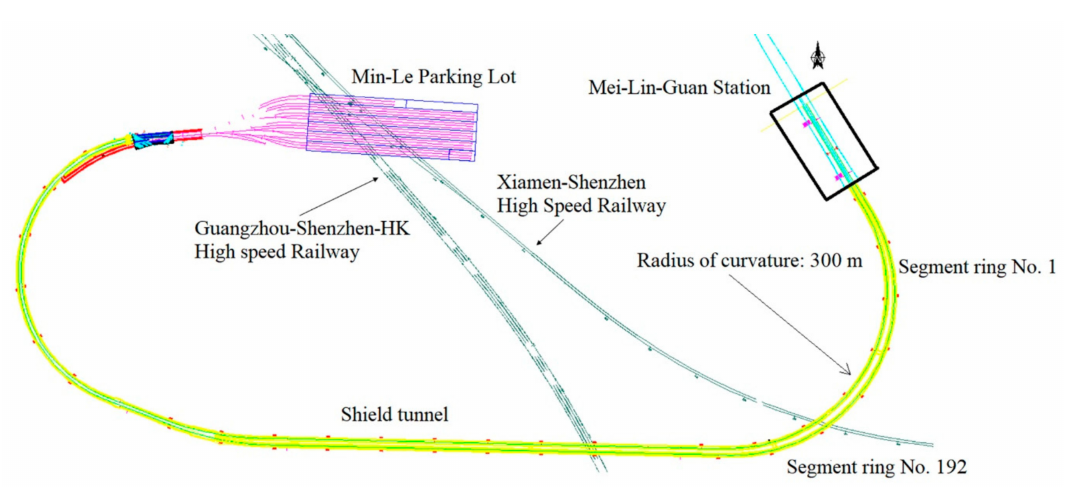
Figure 7. TBM construction interval with the small radius